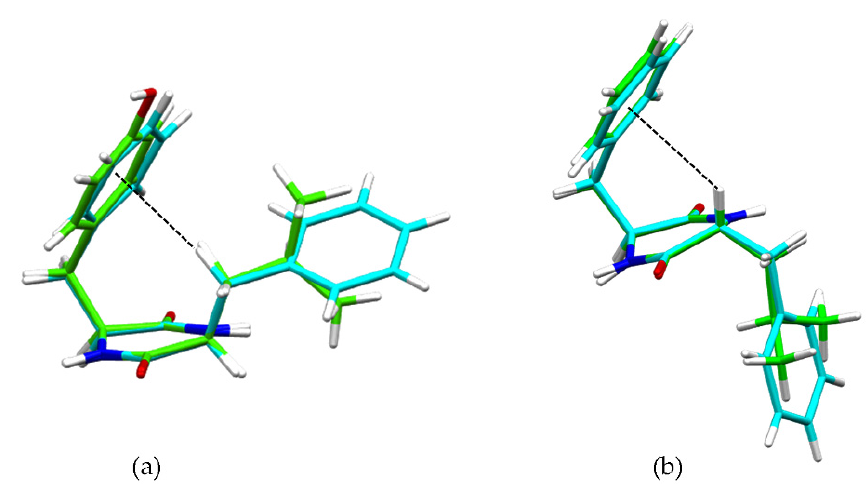
Figure 2. ( a ) Superimposition of single-crystal XRD structures of homochiral cyclo(Tyr-Leu) (green, [49]) and cyclo(Phe-Phe) (cyan, [31]), highlighting the β CH- π interaction (dashed black line). ( b ) Superimposition of single-crystal XRD structures of heterochiral DKP2 (green CCDC 2209459) and DKP4 (cyan, CCDC 2209458) highlighting the α CH- π interaction (dashed black line).